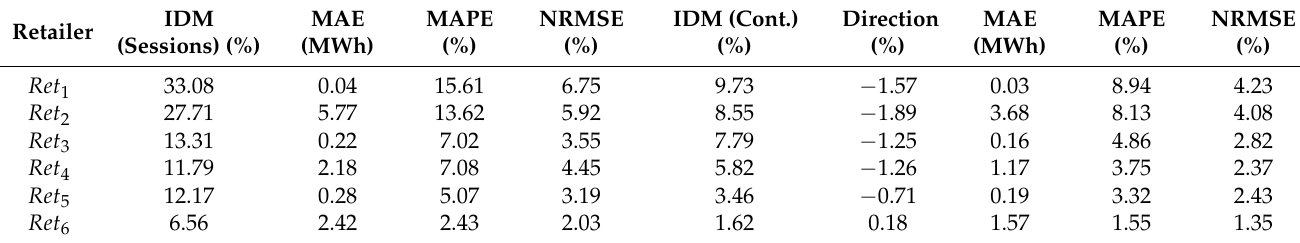
Table 2. Experimental results: energy bids and forecast indicators.